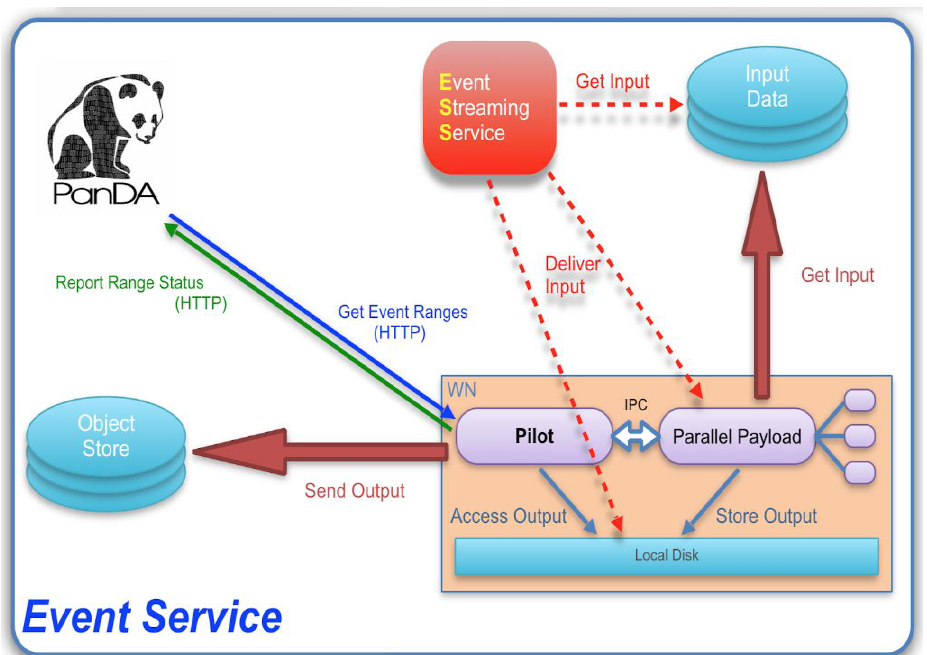
Fig. 1. A schematic view of the ATLAS Event Service and Event Streaming Service